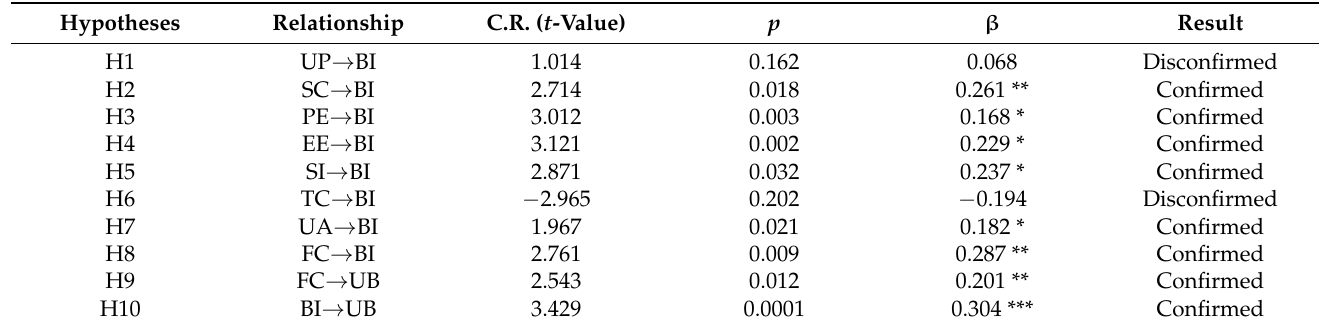
Table 7. An overview of the structural model analysis